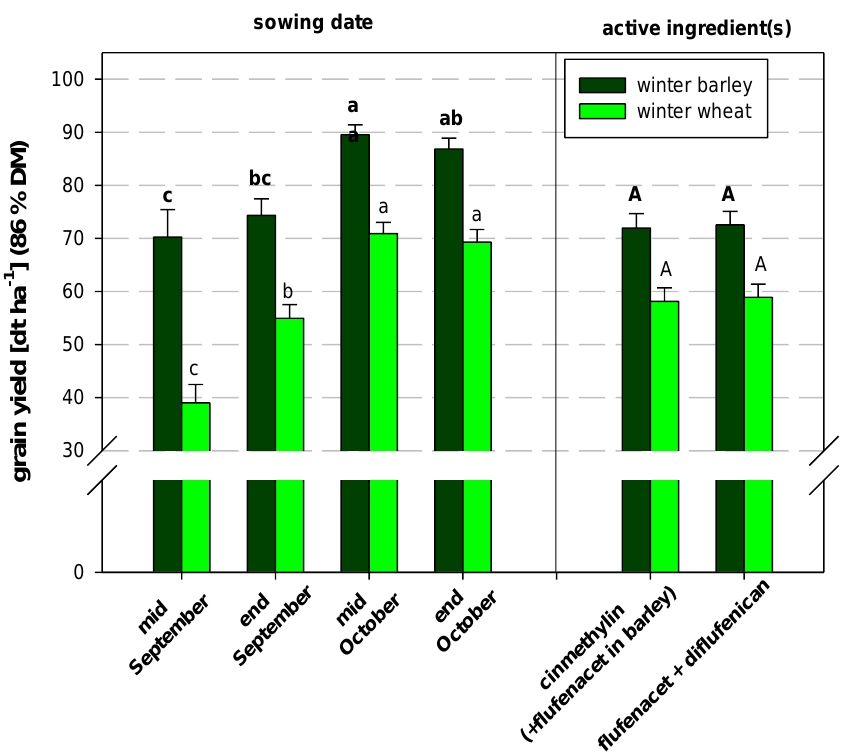
Figure 6. Grain yield, 86% DM [dt ha −1 ] of winter barley and winter wheat depending on sowing date and used active ingredient(s) (winter wheat: 500 g cinmethylin ha −1 , winter barley: 250 g cinme- thylin ha −1 + 144 g flufenacet ha −1 , both crops: 240 g flufenacet + 120 g diflufenican ha −1 ), error bars = standard error, different letters indicate significant differences between sowing date or herbicide treatment (bold letters: winter barley), p ≤ 0.05, Tukey -HSD-Test.